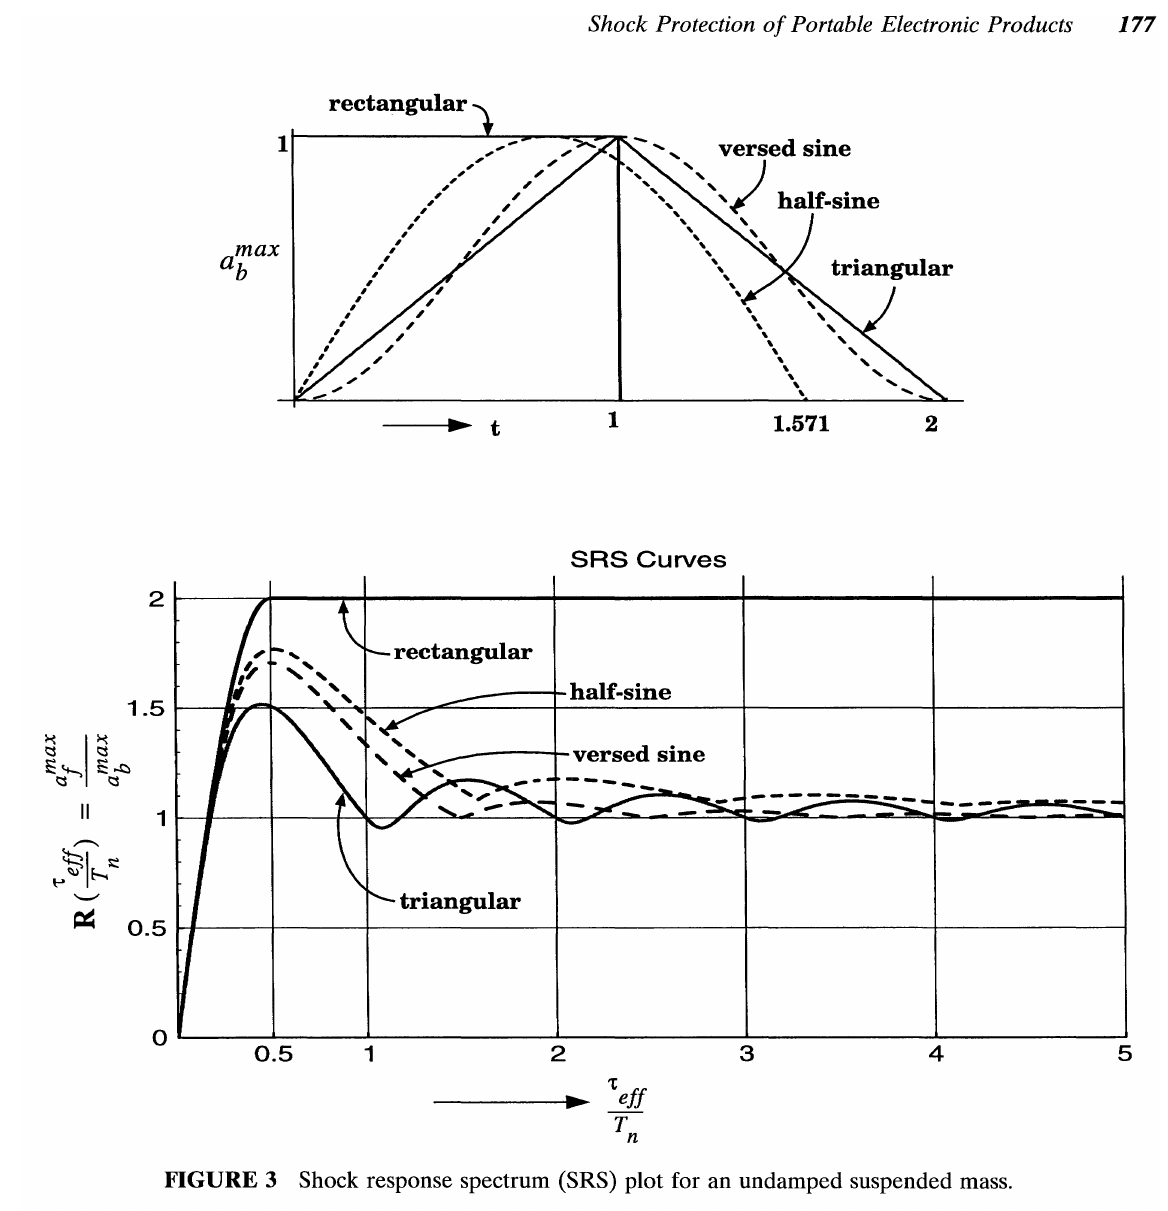
FIGURE 3 Shock response spectrum (SRS) plot for an undamped suspended